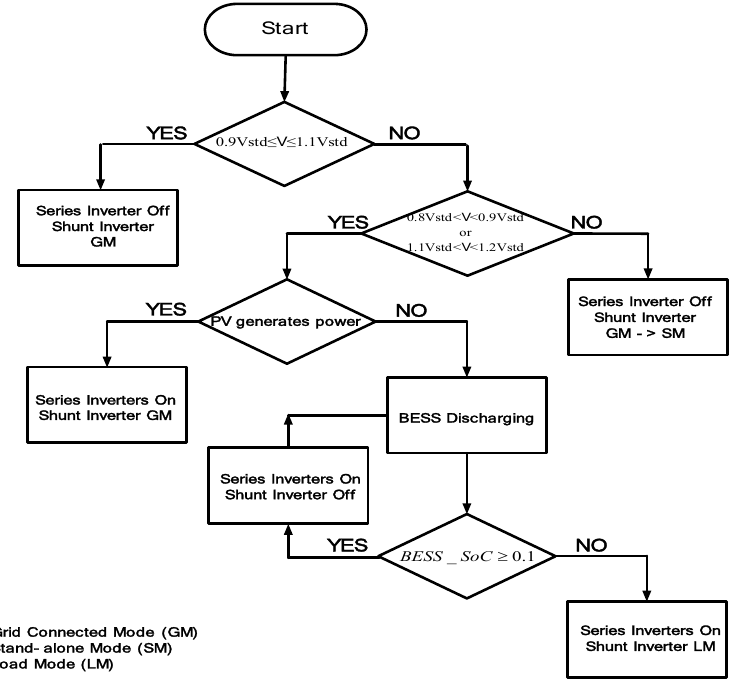
Figure 12. Flowchart for proposed PV system for voltage compensation method.